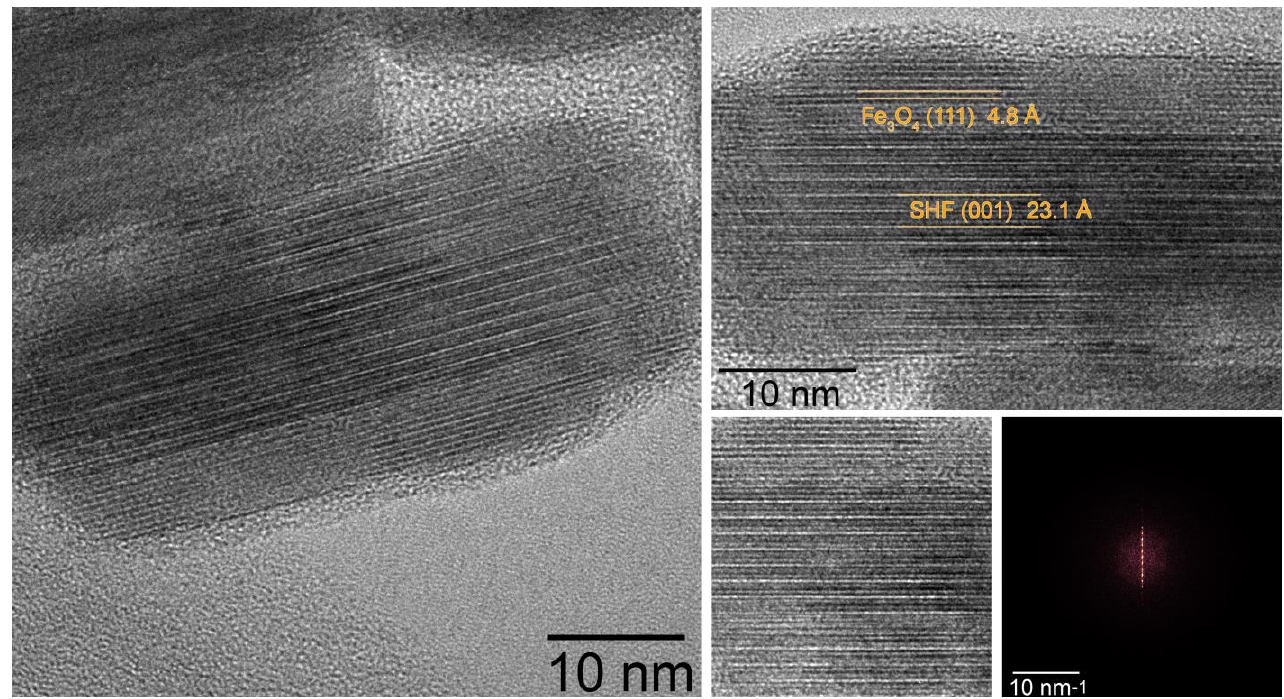
Figure 2. HRTEM image of FO_11 sample composite particle. Right images are cropped parts of the left one; at the right bottom side of the collage, 2D FFT of the cropped square region is